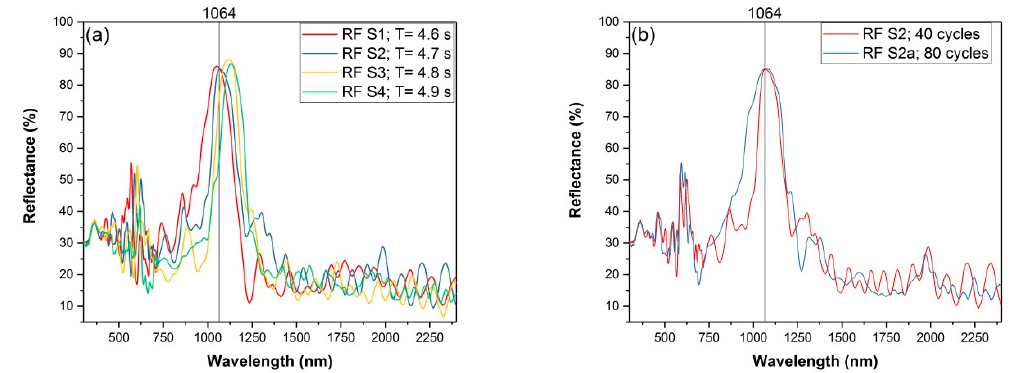
Figure 4. Reflectance spectra of pSi RFs ( a ) pSi RFs prepared using same sinusoidal current densities and same number of different periods ( b ) pSi RFs prepared with same period but different number of cycles. The vertical lines represent the wavelength of FT-Raman excitation (1064 nm).